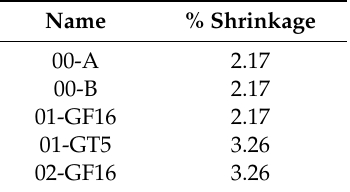
Table 7. Shrinkage Table 7. Shrinkage percentage.